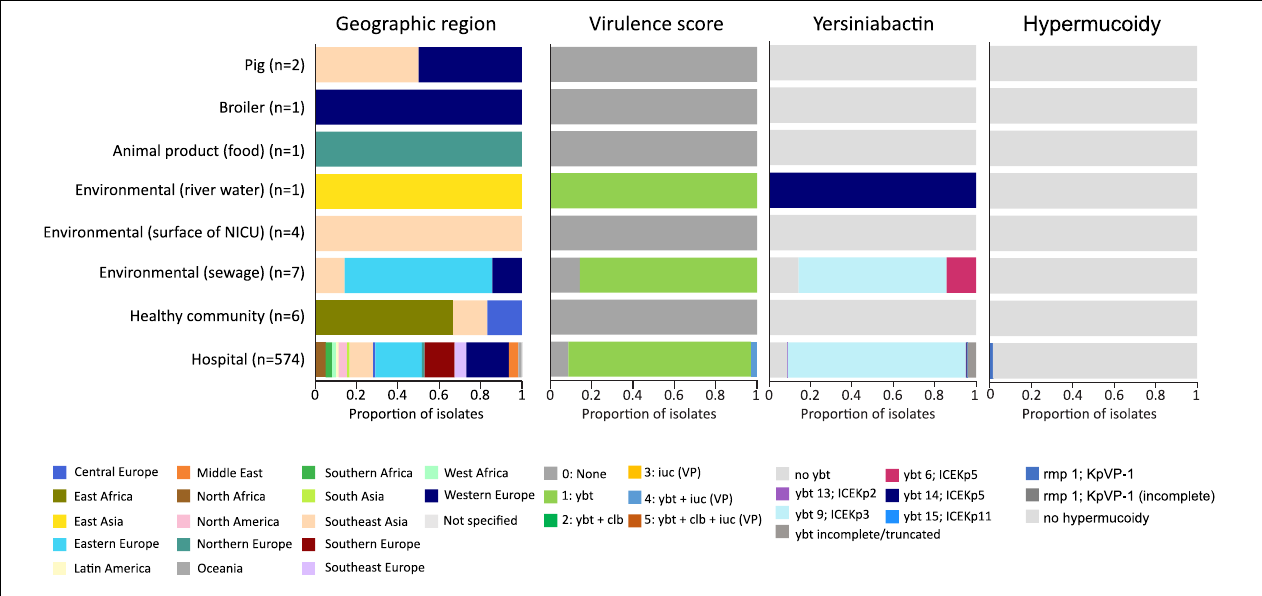
FIGURE 4 | Virulence score, presence of yersiniabactin siderophore and hypermucoidy detected in an international collection of hospital-associated, livestock-associated, community-associated and environmental K. pneumoniae ST101.